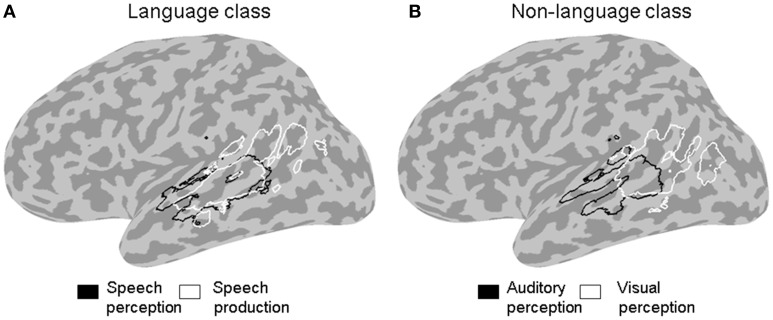
ALE outline maps. Outline maps of pairs of functional categories in the language (A) and the non-language (B) functional classes that showed significant differences in activation likelihood in the left STS at a corrected error probability of α < 0.05.